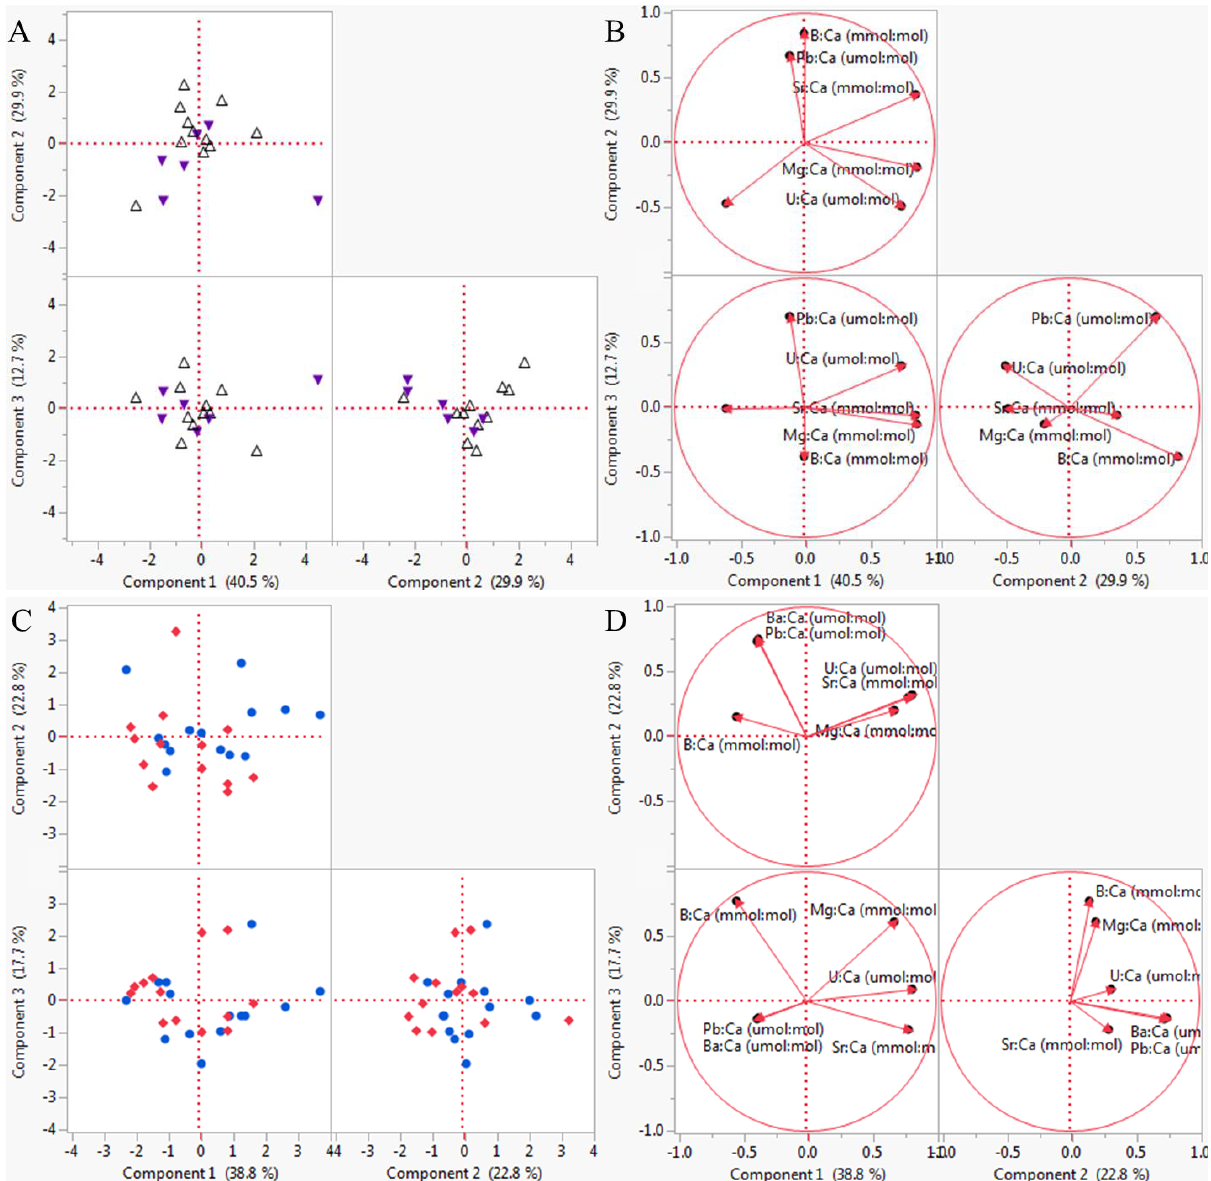
Figure 4. Principal component analyses. Experiment 1: ( A ) Score plots among treatment groups; ( B ) Loading plot (correlation matrix, elemental menu = B:Ca, Mg:Ca, Sr:Ca, Ba:Ca, U:Ca). Purple = low pHOx; Black = high pHOx. Experiment 2: ( C ) Score plots among treatment groups; ( D ) Loading plot (correlation matrix, elemental menu = B:Ca, Mg:Ca, Sr:Ca, Ba:Ca, U:Ca). Blue = low [O ]; Red = low 2